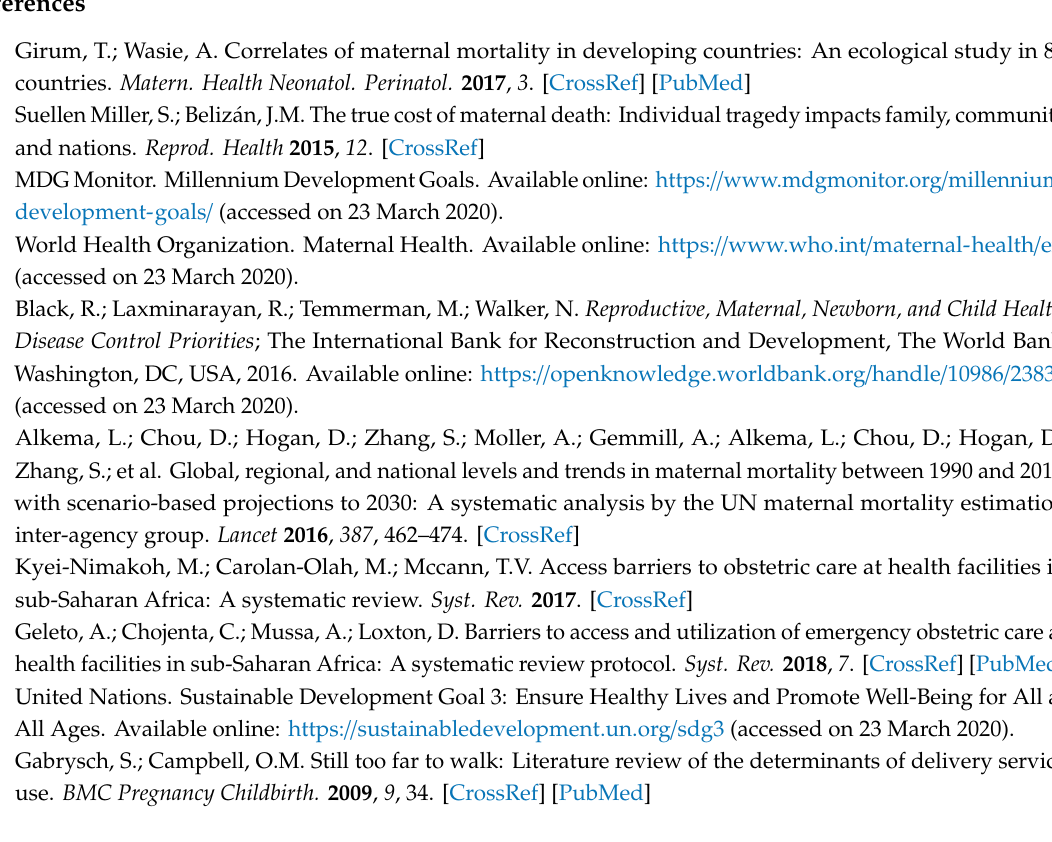
Table S1: Search Strategy, Table S2: Search Strategy for Each Database, Table S3: MMAT Appraisal